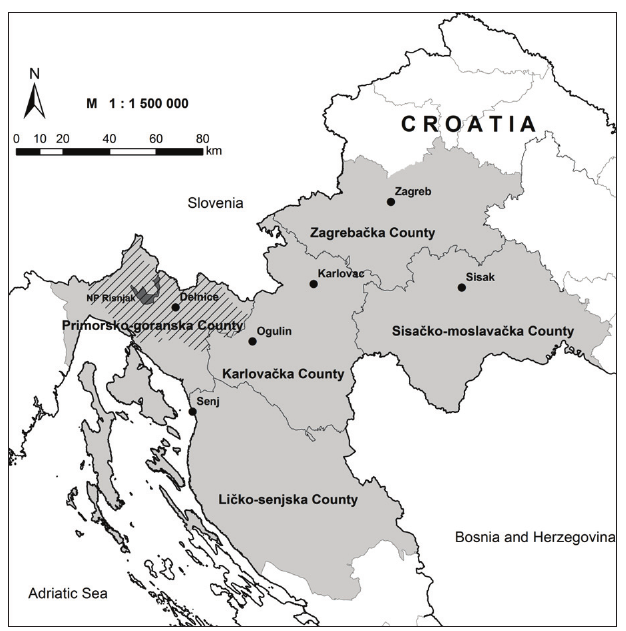
FIGURE 1. The area of 5 Croatian Counties affected by natural hazards including the location of Forest Administrations’ (FA) headquarters and National Park (NP) Risnjak. Hatched area in the Primorsko- goranska County (NP Risnjak, FA Delnice) presents the most damaged forest area by